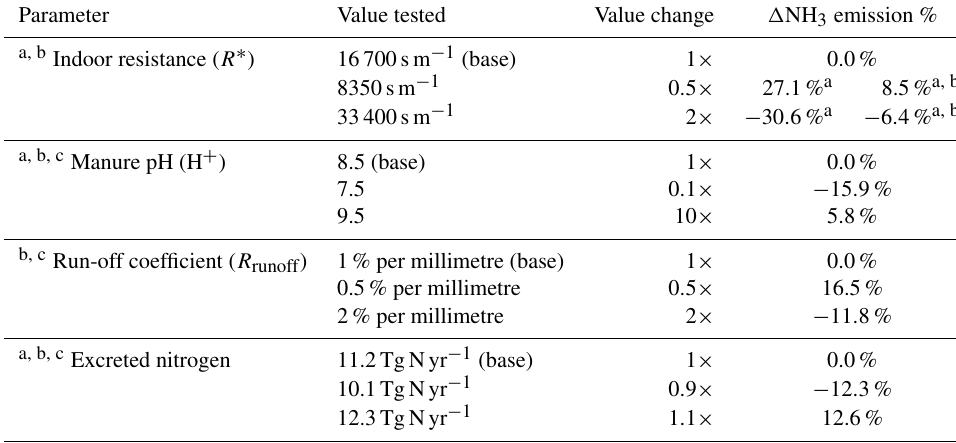
Table 3. Sensitivity test for model parameters for global application of the model. Parameter Value tested Value change (cid:49) NH 3 emission % a, b Indoor resistance ( R ∗ ) 16700sm − 1 (base) 1 × 0.0% 8350sm − 1 0 . 5 × 27.1% a 8.5% a, b 33400sm − 1 2 × − 30 . 6% a − 6 . 4% a, b a, b, c Manure pH (H + ) 8.5 (base) 1 × 0.0% 7.5 0 . 1 × − 15 . 9% 9.5 10 × 5.8% b, c Run-off coefficient ( R × 0.0% runoff ) 1% per millimetre (base) 1 0.5% per millimetre 0 . 5 × 16.5% 2% per millimetre 2 × − 11 . 8% a, b, c Excreted nitrogen 11.2TgNyr − 1 (base) 1 × 0.0% 10.1TgNyr − 1 12.3TgNyr − 1 1 . 1 ×